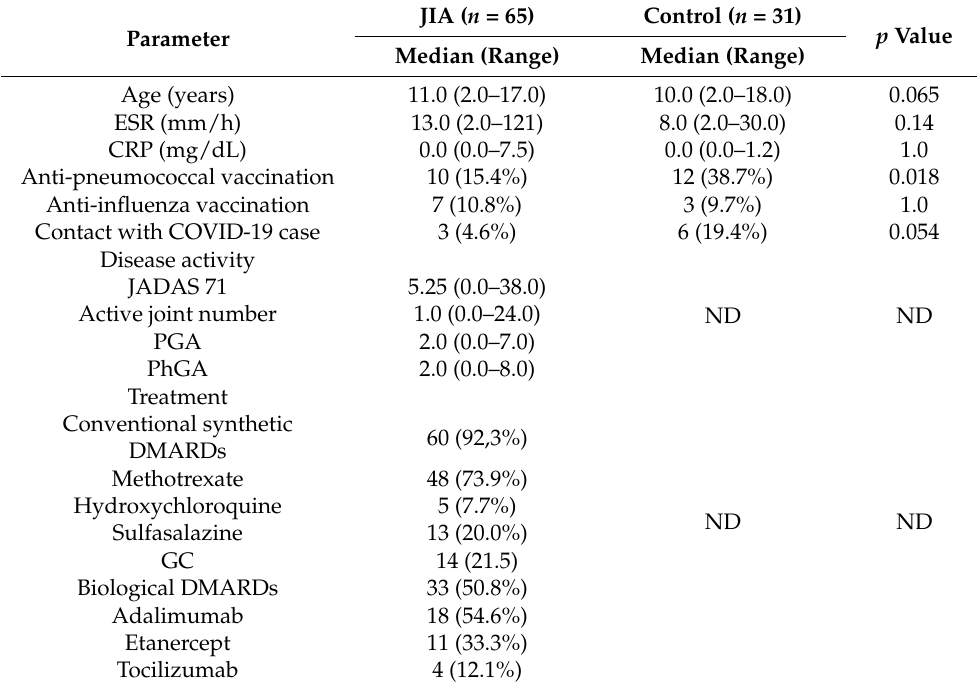
Table 1. Baseline demographic and clinical characteristics of the